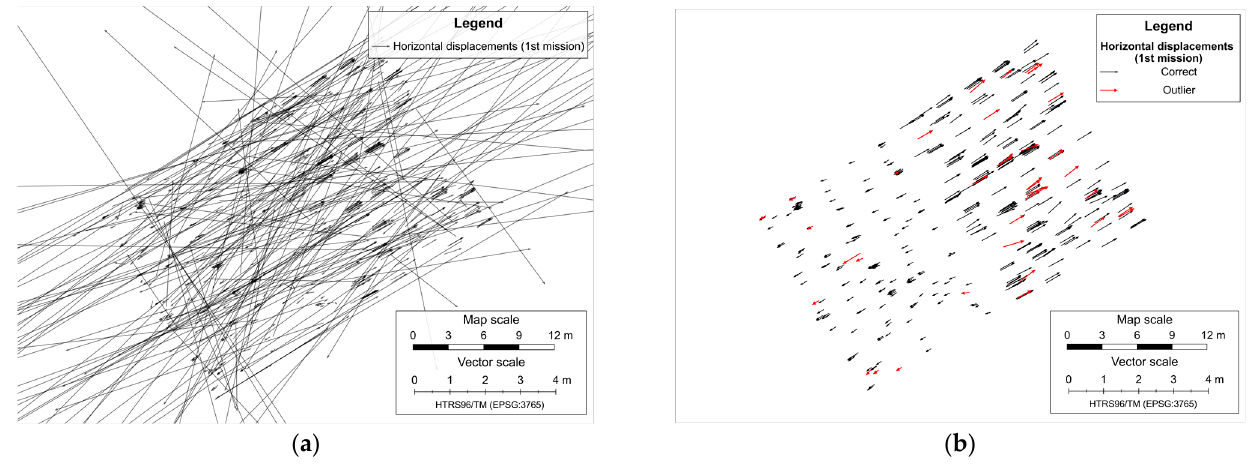
Figure 8. Remaining horizontal displacements vectors in the first mission after the filtering ( a ), correct and final displacement vectors with highlighted outliers in the first mission ( b ).